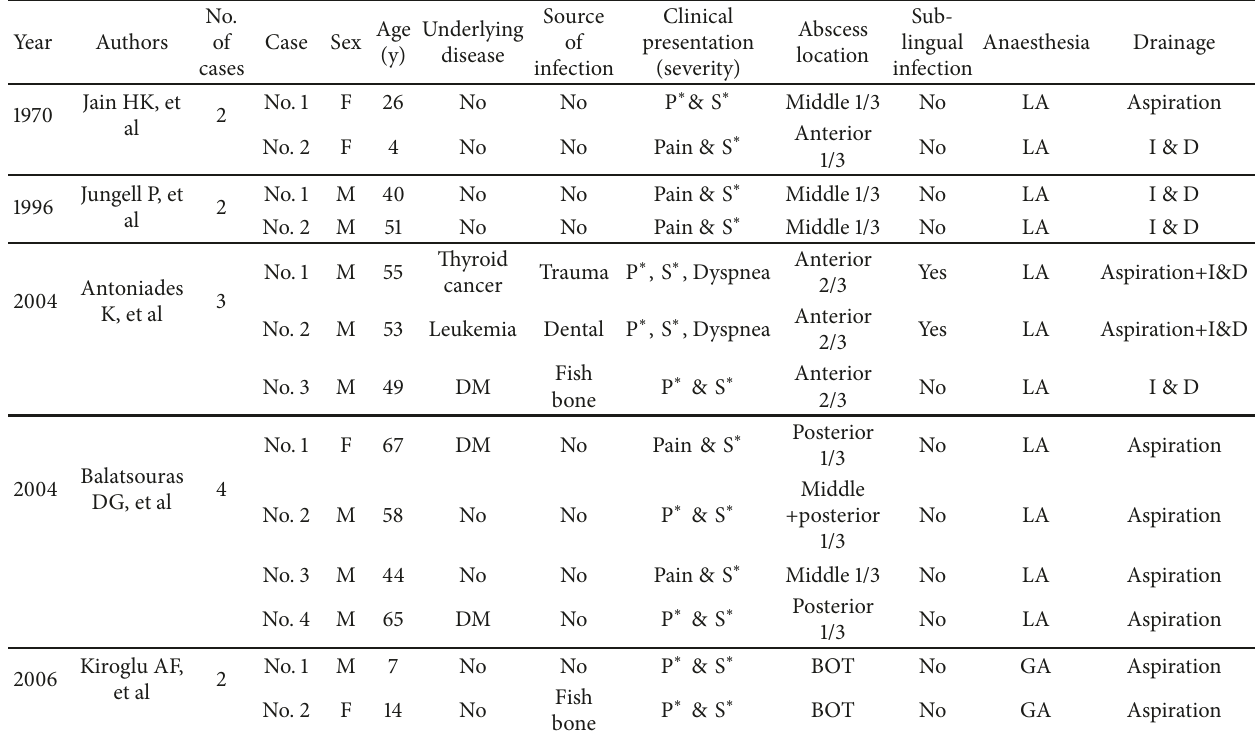
Table 3: Summary of the prior case series of lingual